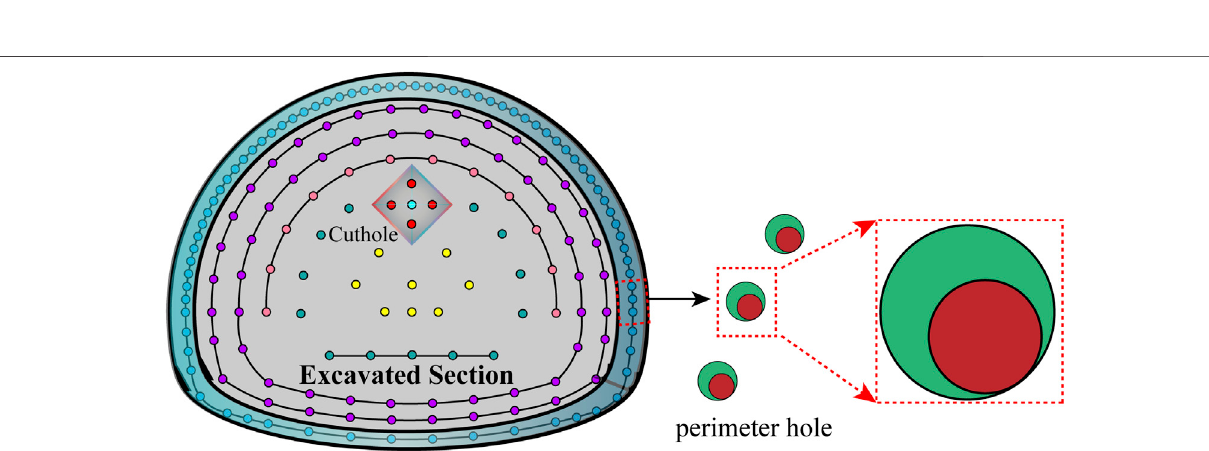
Frontiers in Earth Science |